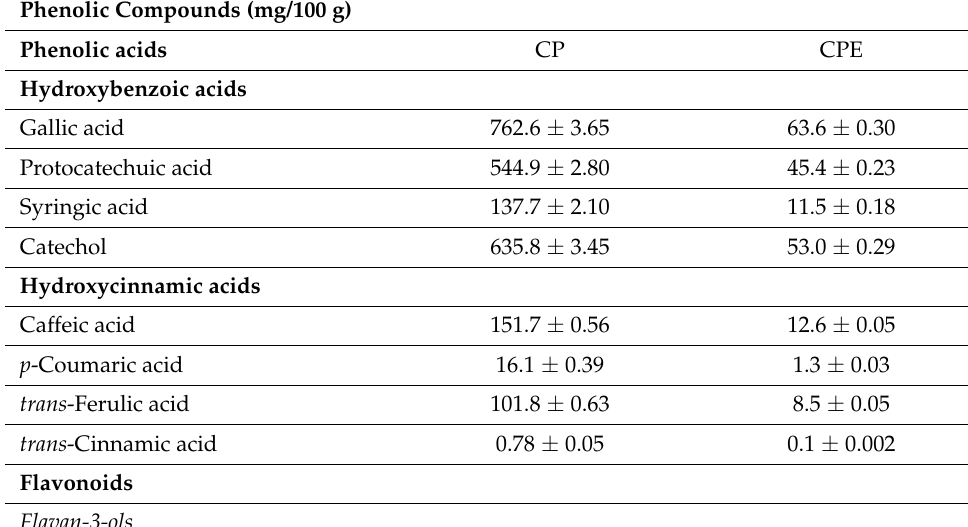
Table 1. Oxidative characteristics and antimicrobial activities of clove powder (CP) and clove powder extract